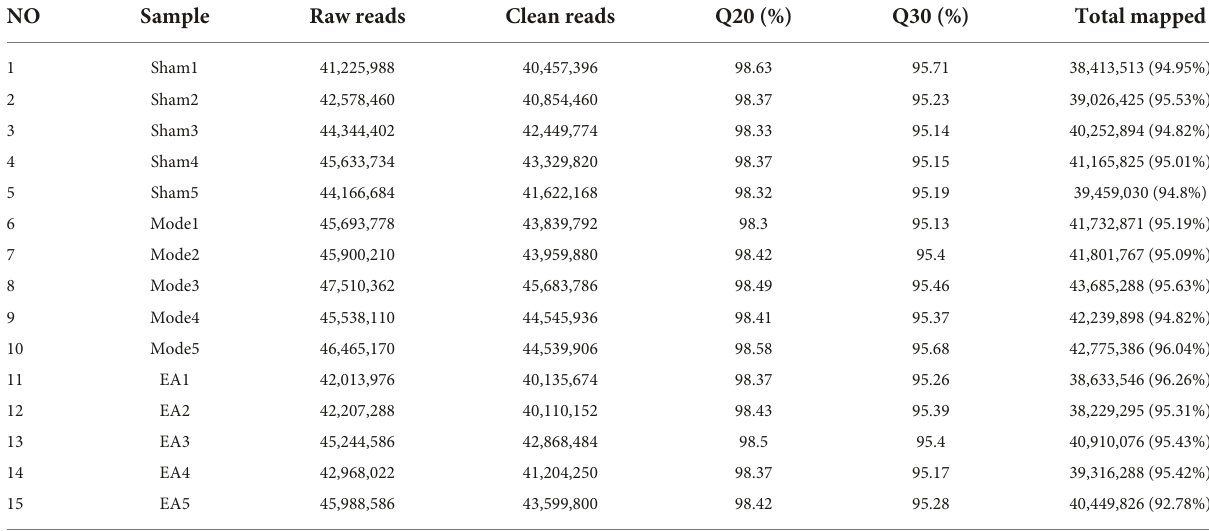
TABLE 1 Quality control and sequencing information for samples.